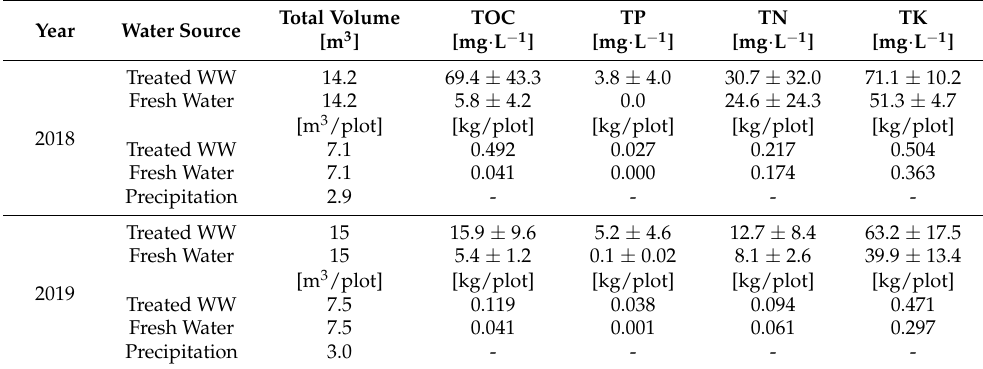
Table 5. Quality of the irrigation water